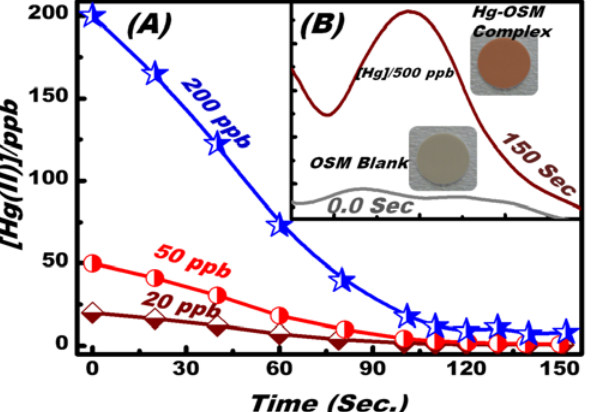
Figure 3. Effect of time on the uptake of Hg(II) on the OSM at different Hg(II) concentrations. The inset shows the reflectance spectra for OSM (blank) and OSM–Hg(II) ions uptake at pH 5 and color transition map tested at the total volume of 20 mL and temperature of 20 °C.